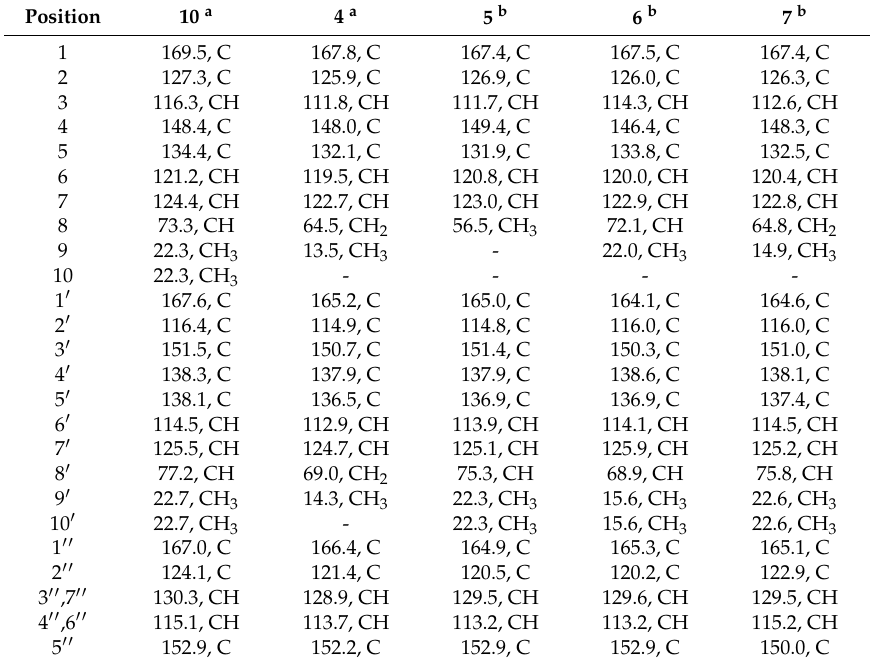
Table 5. 13 C NMR data for 4 – 7